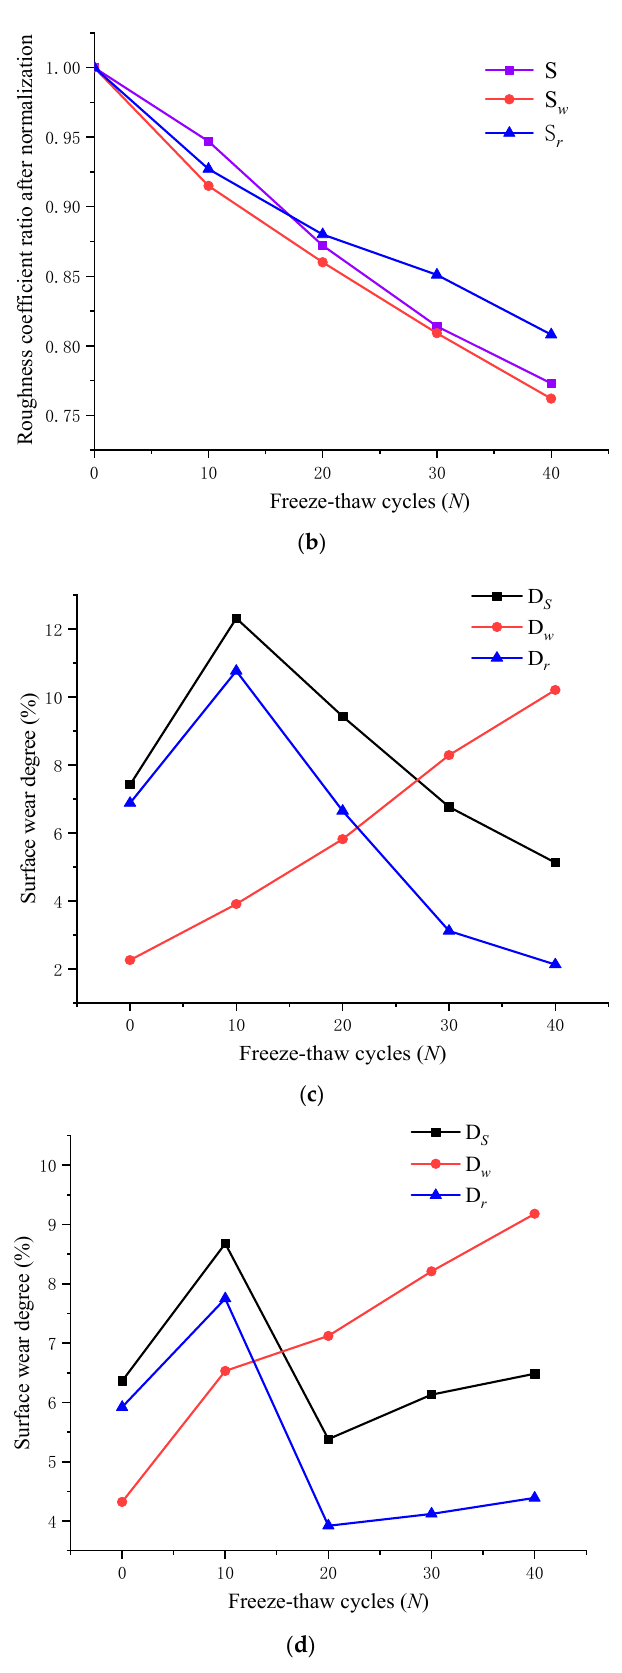
Figure 12. Variation of three-dimensional roughness parameters of the shear surface under freeze- thaw cycles. ( a ) Surface roughness coefficient after the second shear test. ( b ) Surface roughness co- efficient after the third shear test. ( c ) Surface wear degree of the jointed rock specimens after the second shear test. ( d ) Surface wear degree of the jointed rock specimens after the third shear test. (1) After freeze-thaw cycles, S , w S and r S of the shear surface show an overall downward trend, indicating that both the original shear surface and the Gaussian filtered large-scale waviness surface and the small-scale unevenness surface show an overall de- crease in surface roughness after freeze-thaw cycles. Due to freeze-thaw degradation, the asperity is more prone to wear in the shearing process, which leads to the decrease of the shear surface undulation and the flattening of surface morphology. The w S curve of the waviness surface gradually becomes steeper, while the